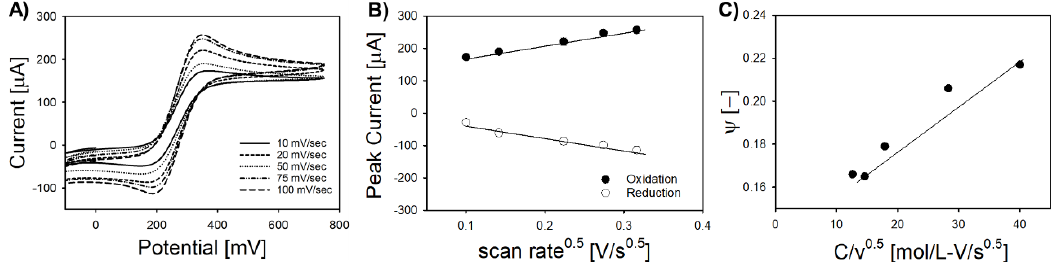
Figure 2. Electrochemical characterization of Pt-IME for gap spacing of 50 μm. ( A ) Representative cyclic voltammograms in 4 mM K 4 Fe(CN) 6 + 1 M KNO 3 at room temperature. ( B ) Randles–Sevcik plots for oxidative and reductive peak current indicate diffusion-limited transport to the Pt-IME. ( C ) Nicholson plots for the determination of heterogenous electron transfer (HET) constant (k 0 ). Full analysis of all Pt-IME electrode gap spacing (with replicates) can be found in the supplemental section.